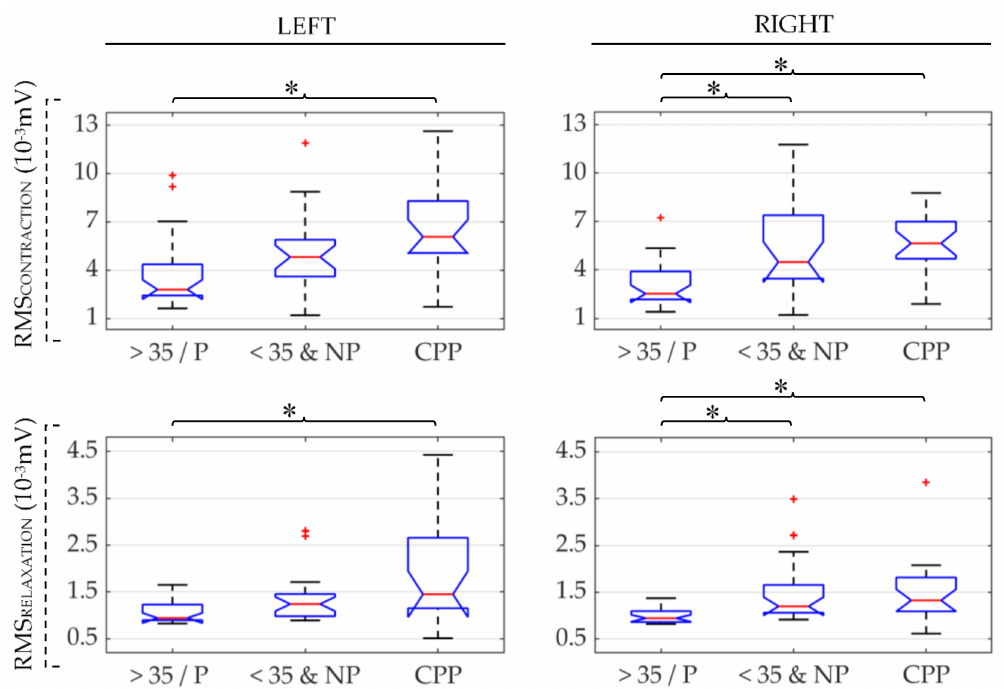
Figure 3. Box-whisker plots of root mean square (RMS) values of the left and right PFM (left and right subfigures, respectively) in patients (CPP), healthy women over 35 and/or parous (>35/P) and healthy women under 35 and nulliparous (<35&NP) during PFM contraction and relaxation (first and second rows, respectively). (*): significant difference between groups under the ends of the brace. Red (+): outlier within the group’s data